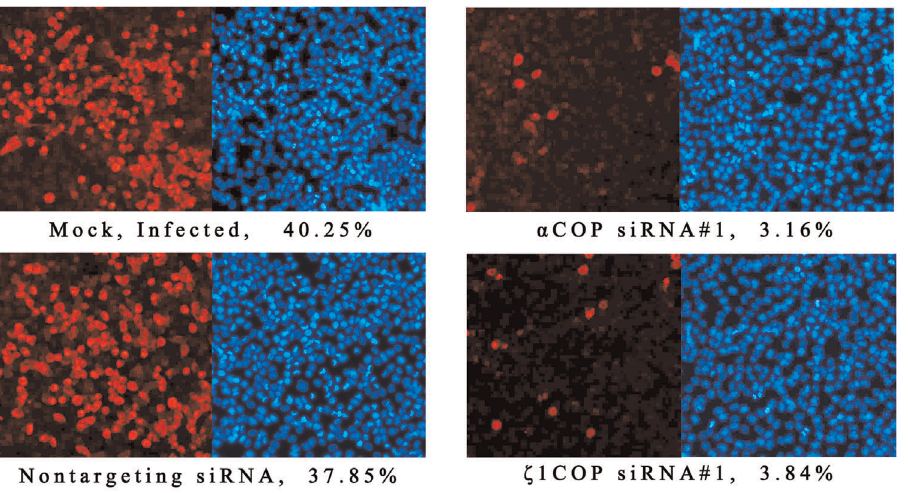
Figure 3. COPI depletion protects RD cells from EV71 infection. RD cells were transfected with a COP and f 1COP siRNA and infected with EV71. At 24 hpi, cells were fixed with 4% paraformaldehyde and permeabilized. EV71 infection was determined by immunofluorescence staining on VP1. RD cells were observed by DAPI.